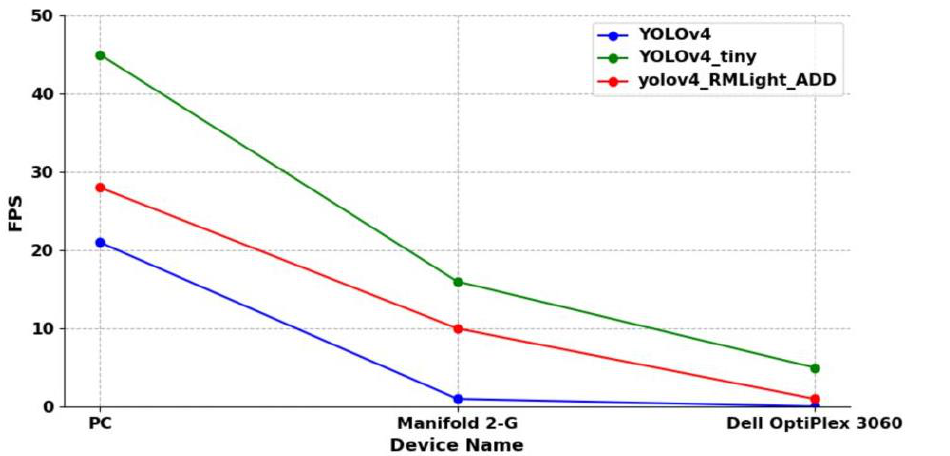
Figure 14. FPS test results. The vertical axis indicates the FPS value of the model for real-time detection. The horizontal axis indicates the different